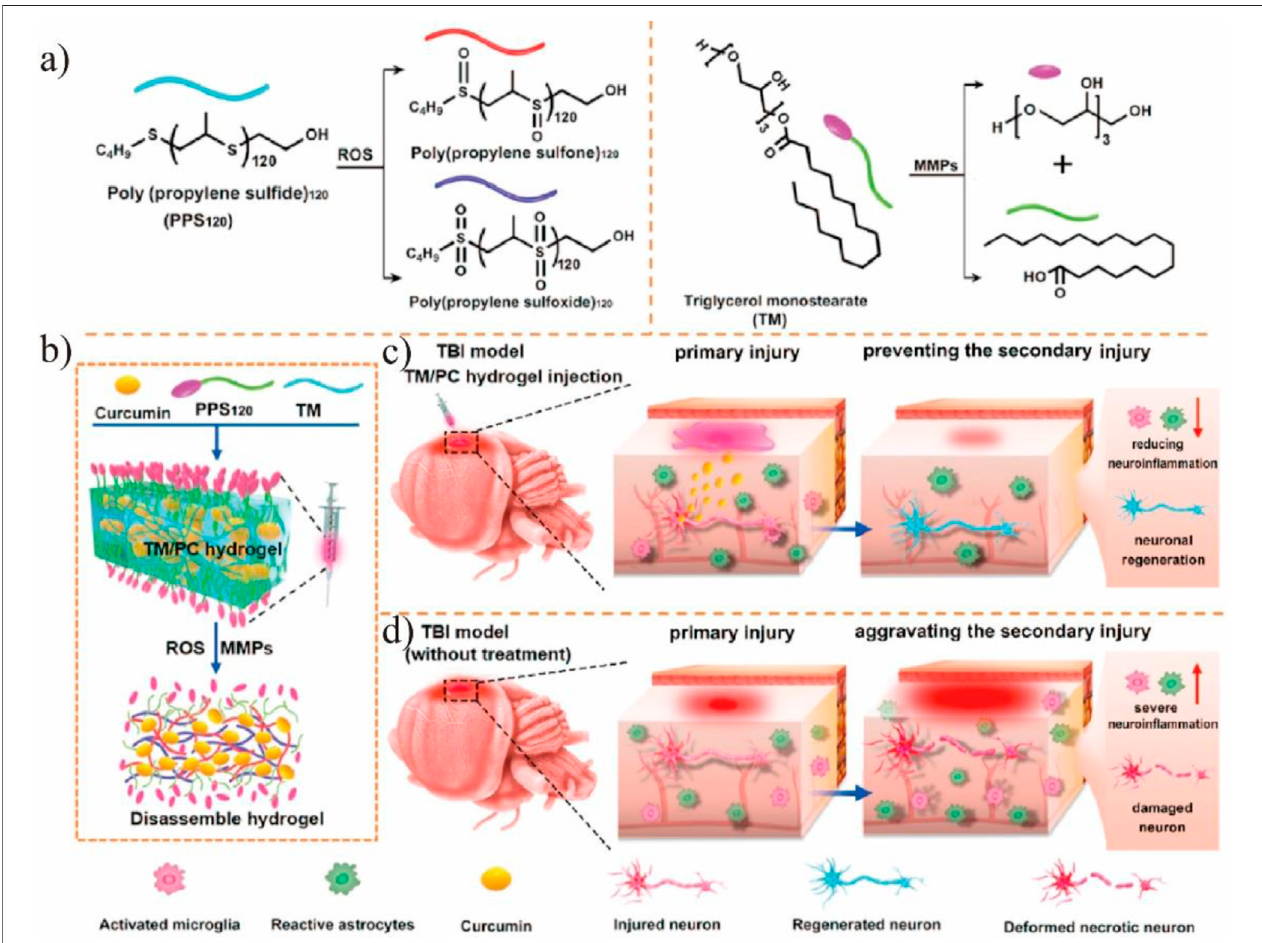
FIGURE 4 | (A) PPS 120 switched from a hydrophobic polymer to the hydrophilic poly (propylene sulfone) 120 and poly (propylene sulfoxide) 120 in the ROS environment and TM could be cleaved by MMPs. (B) Schematic illustration of TM/PC hydrogel preparation procedures and their degradation process under MMP and ROS conditions. (C) In situ injection of TM/PC hydrogels within the postsurgery TBI: TM is degraded, and PPS120 scavenges ROS to release Cur, reducing neuroin fl ammation and neuronal death. (D) Without hydrogel treatment, neuronal death and severe neuroin fl ammation were observed, and the secondary injury was aggravated. Reproduced from Qian et al. (2021) with permission from the